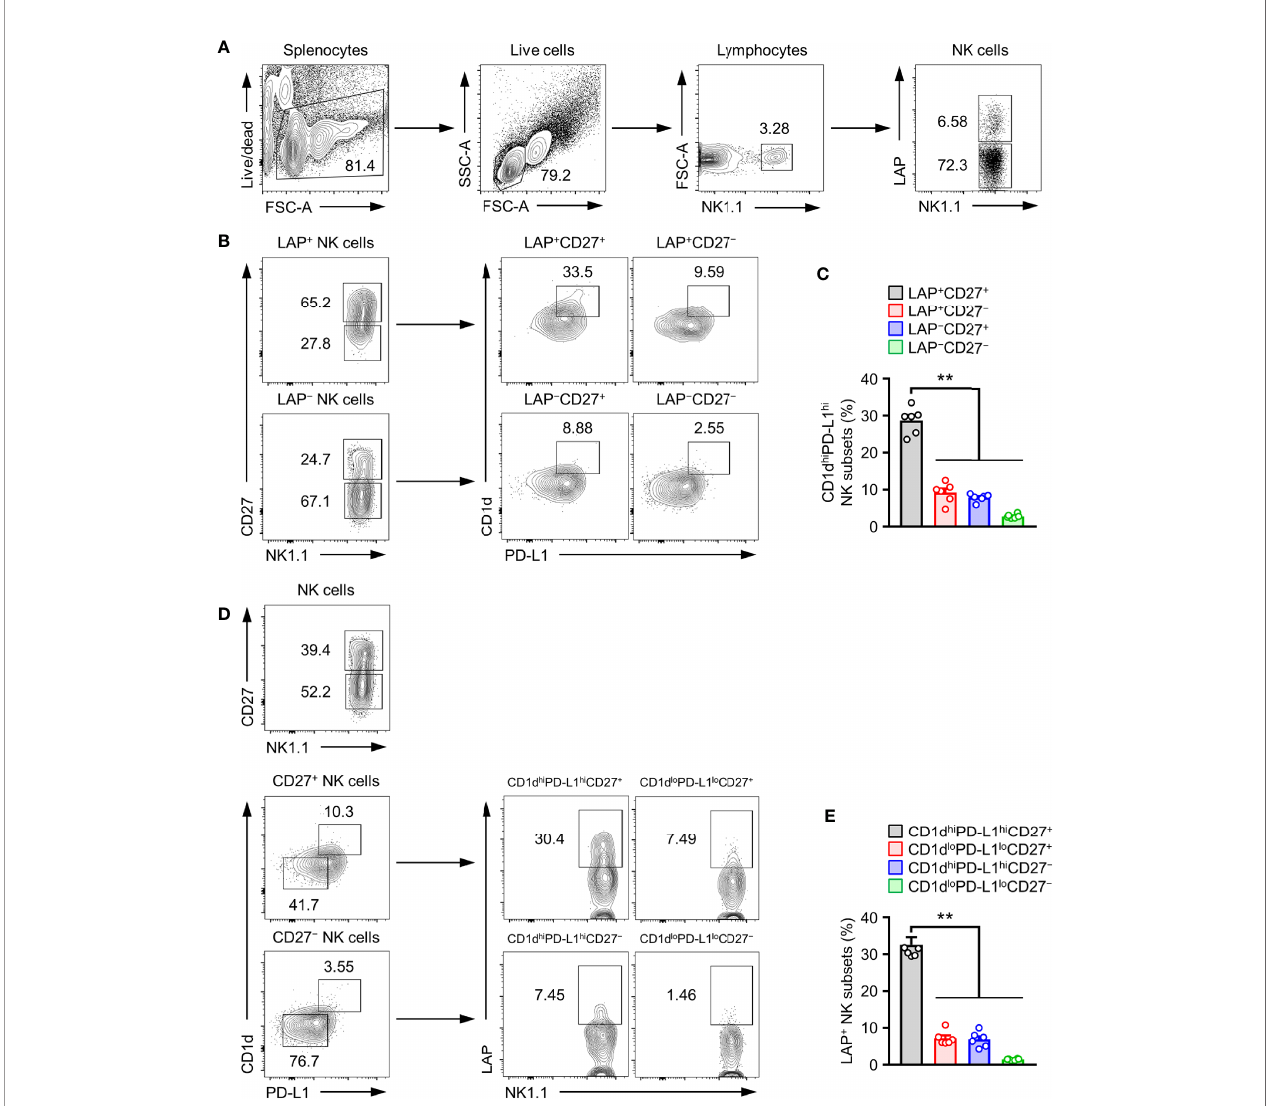
FIGURE 3 | CD1d hi PD-L1 hi CD27 + subset is TGF- b -Producing regulatory NK cells. (A) Gate strategies for LAP + NK cells. (B) Representative fl ow cytometry images, (C) Histograms for the frequency of CD1d hi PD-L1 hi subsets in LAP + CD27 + NK cells (n = 6). (D) Representative fl ow cytometry images and (E) histograms for the frequency of LAP + subsets in CD1d hi PD-L1 hi CD27 + NK cells (n = 6). Data are expressed as mean ± SEM. ** p <